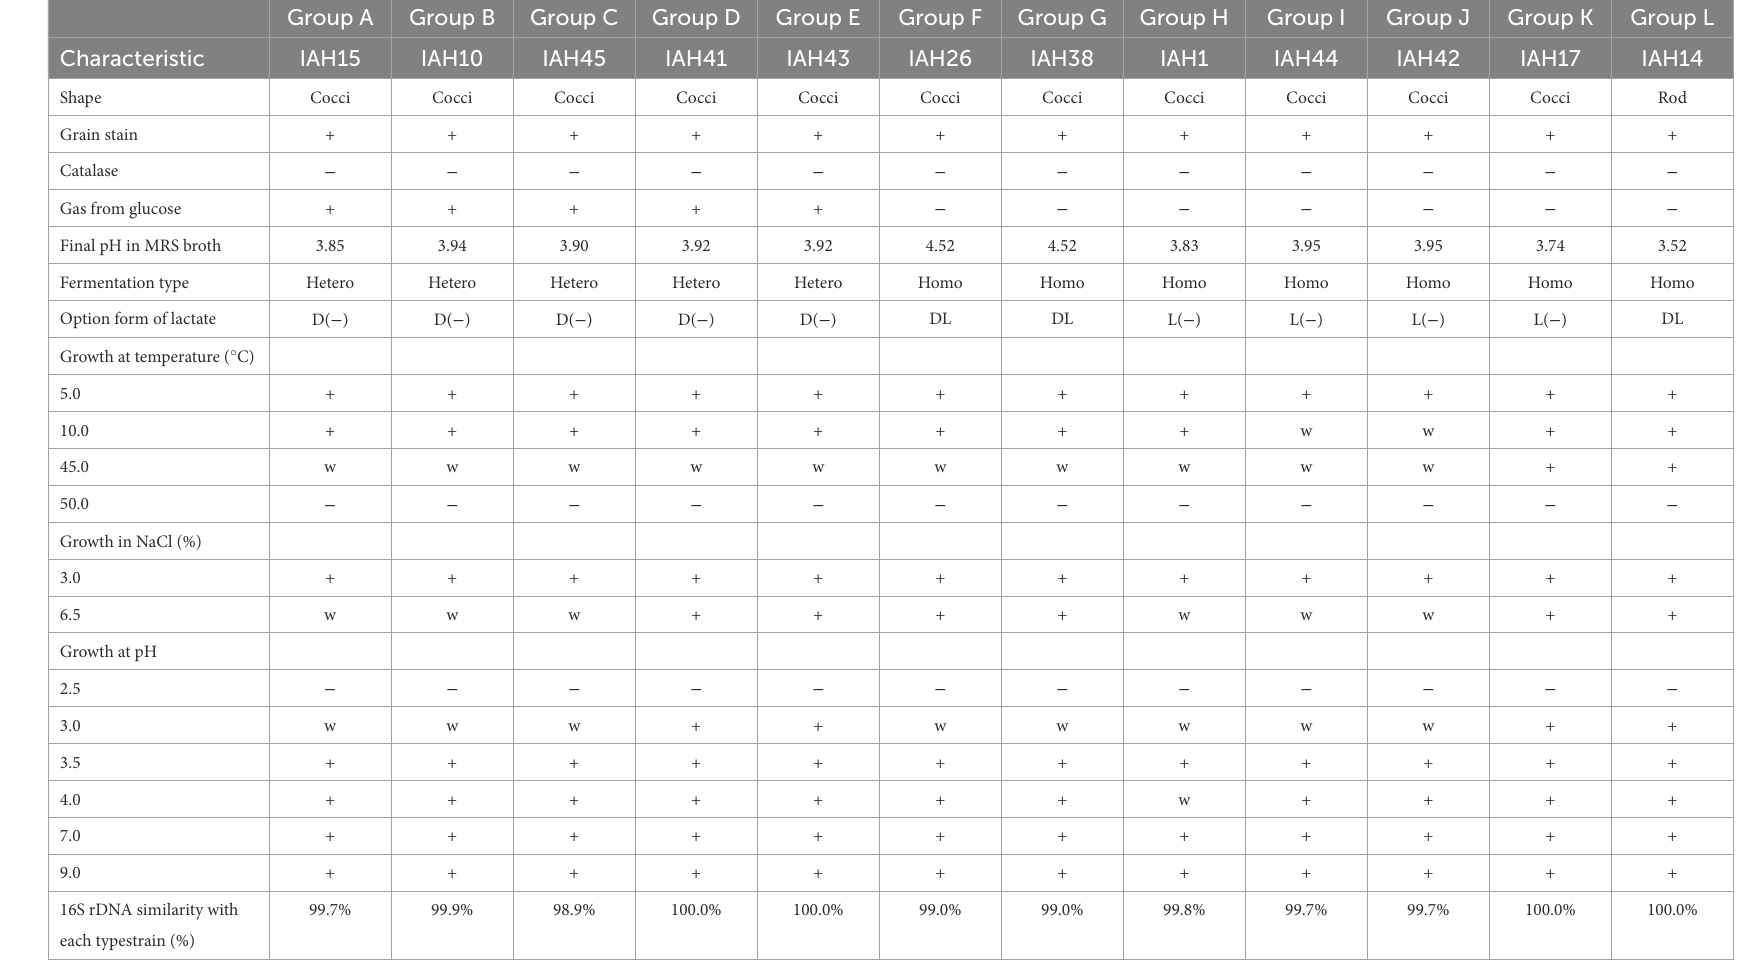
TABLE 5 Characteristics of representative strains isolated from natural grasses.